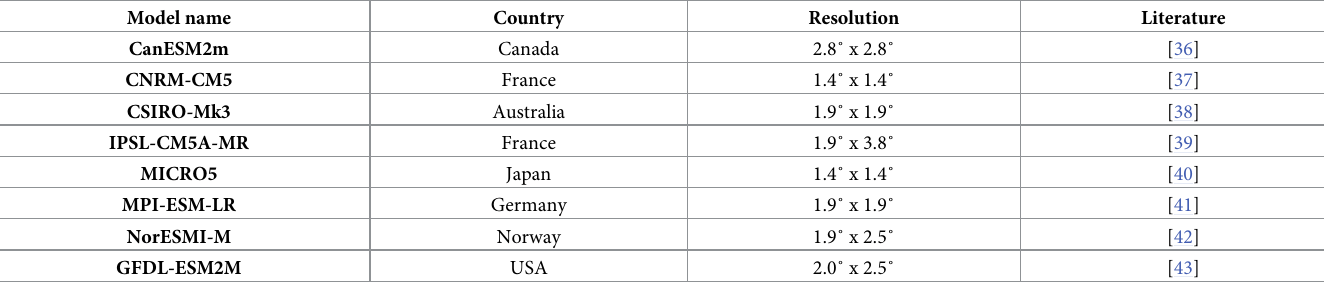
Table 2. Summary of the Global Circulation Models (GCMs) used in the study. Model